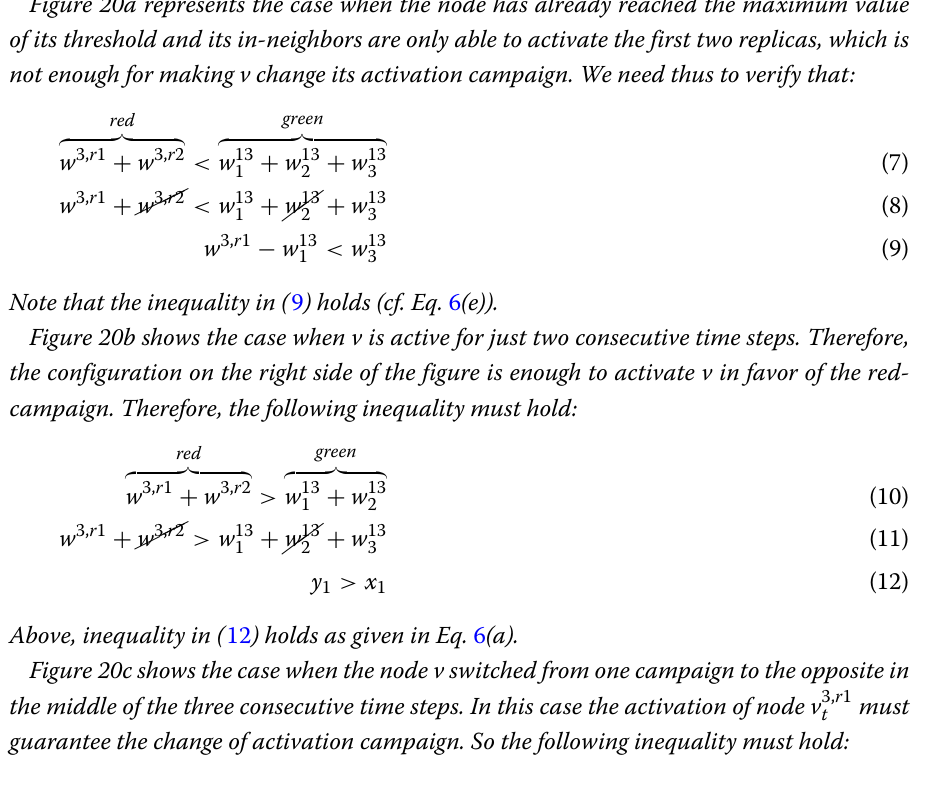
Figure 20a represents the case when the node has already reached the maximum